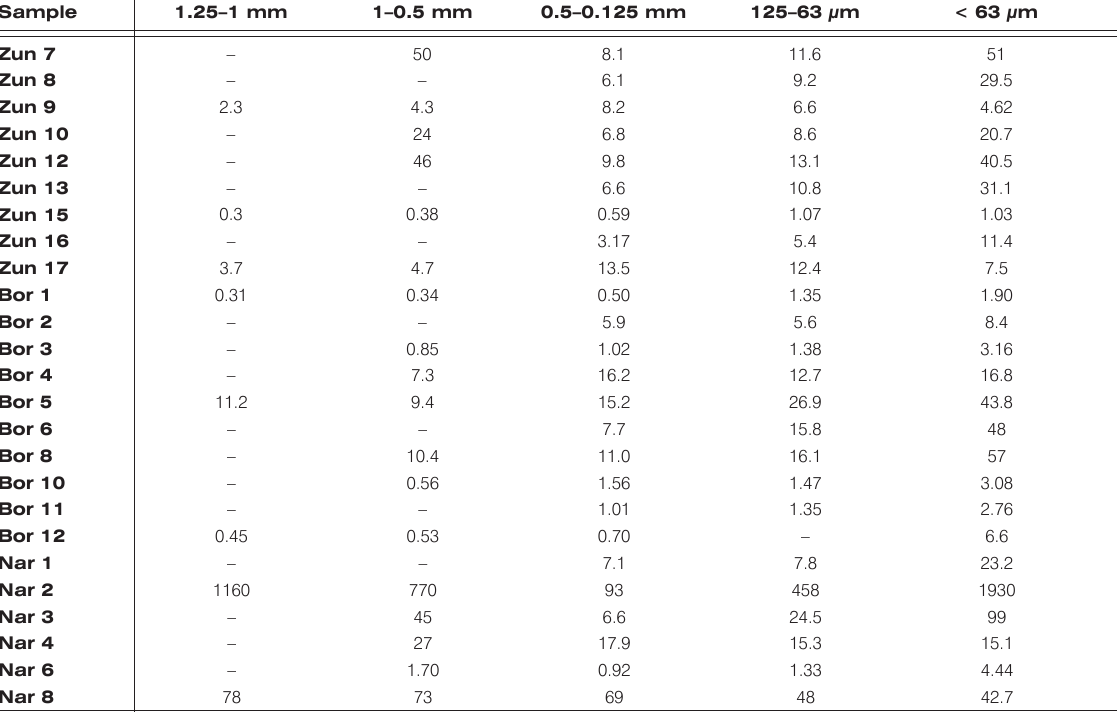
Table 4. Total mercury content of subsamples in mg kg -1